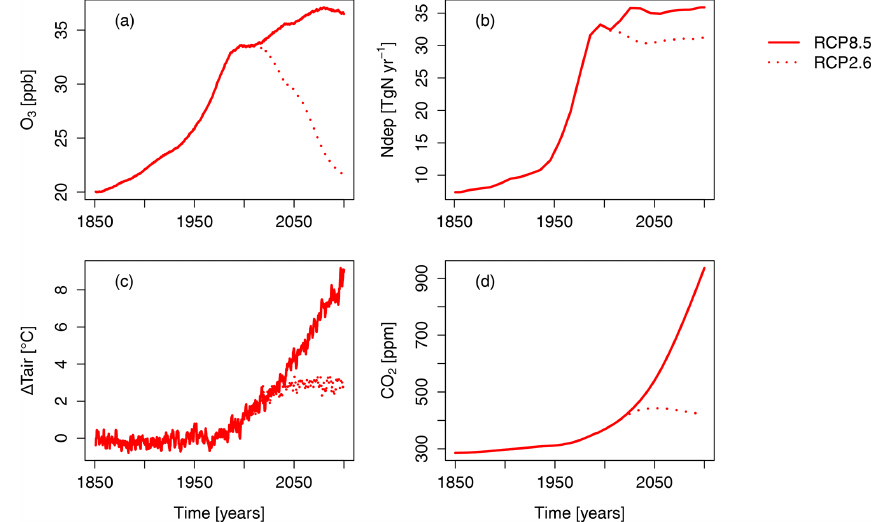
Figure 1. Time series of the terrestrial northern hemispheric ( ≥ 30 ◦ N) mean (a) near-surface O 3 concentration, (b) summed nitrogen deposition, (c) air temperature at 2m height, and (d) atmospheric CO 2 concentration according to the RCP2.6 and RCP8.5 emission scenario. For visual clarity, the effect of the seasonal cycles of near-surface O 3 and N deposition are smoothed by a moving average of 12 months. See Figs. S1 and S2 for spatial patterns of nitrogen deposition and near-surface O 3 . Table 1. Forcing setting of the factorial runs. Climate forcing for the years prior to 1901 is always drawn from the same random sequence of years between 1901 and 1930. Factorial run CO 2